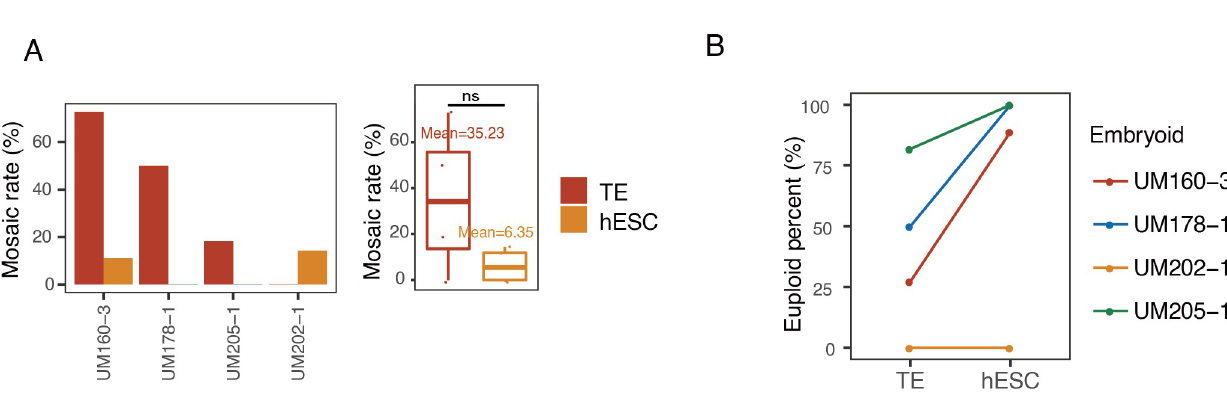
Fig 3. Analysis of chromosome copy number of TE and corresponding hESC from the same embryo. A) Mosaic rates of the matched TE-hESC of each embryo (left) and the corresponding distribution (right) (n = 4). hESC showed lower mosaic rate than corresponding TE in each embryo. n, number of embryos. B) Euploid percent of the matched TE-hESC of each embryo. hESC showed higher euploid percentage than corresponding TE in each embryo.